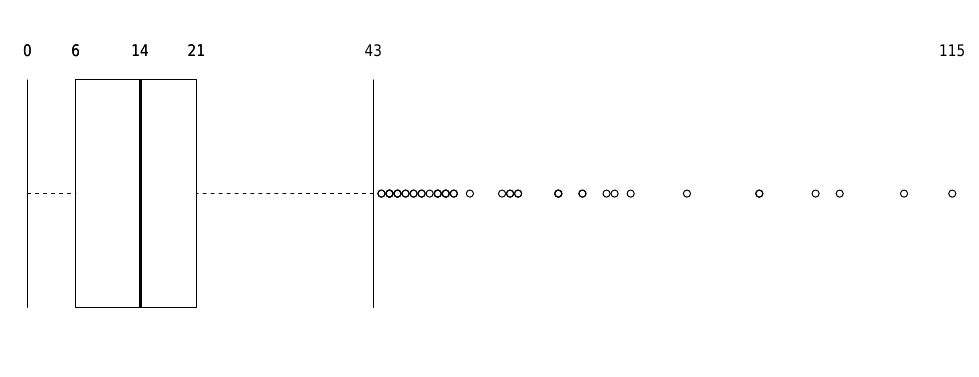
( a ) Box plot of RSSI maximum fluctuation value parameter from the isolated patterns of data stream collected by the proposed hardware at Steinfurter Straße (Unit: Strength= dBm).